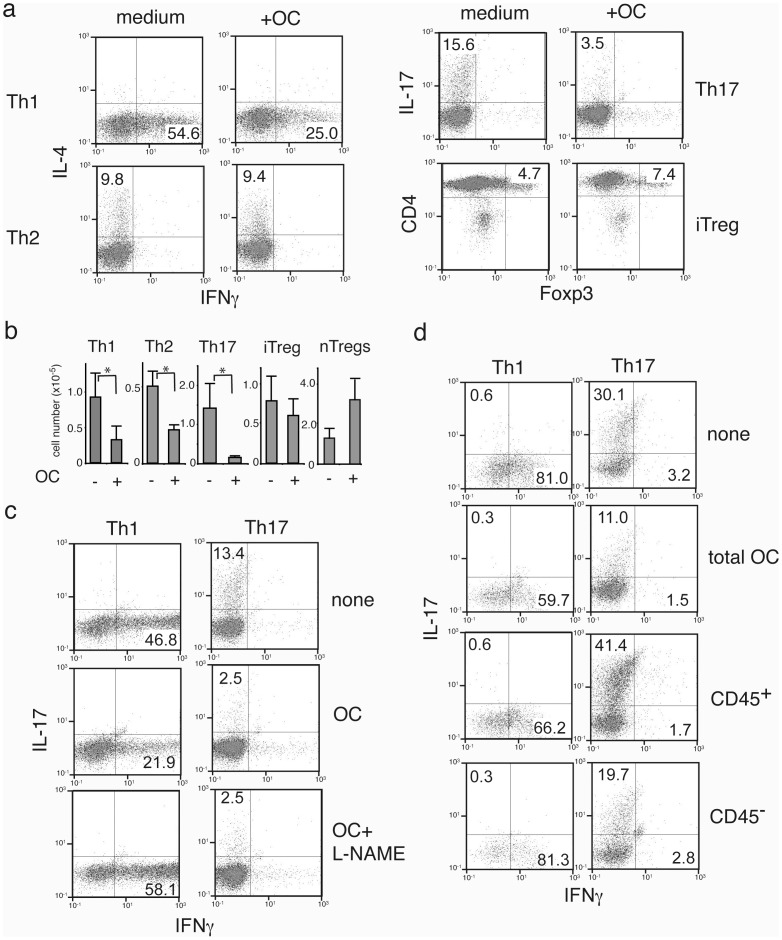
Suppression of effector but not regulatory T cells by omentum cells.(a) Immunosuppressive functions of omentum cells on effector T cells. Naïve CD4+ T cells were induced to differentiate into Th1, Th2, Th17, or iTregs. 5 days after induction, omentum cells were added to each group of cells. T cells were maintained further with the same culture medium for 2 days, harvested, and were stimulated with PMA and ionomycin for 4 hours to induce cytokine production. (b) Cells were cultured with (+) or without (−) omentum cells and treated as in (a). Cell numbers that are expressing IFNγ, IL-4, IL-17, or Foxp3 were determined after intracellular cytokine stain. For nTregs, CD4+CD25+ from spleen were expanded prior to co-culture for 2 weeks, then cultured with omentum cells for 2 days. (c) Effect of iNOS inhibitor on Th1 and Th17 inhibition by omentum cells. Differentiated Th1 or Th17 cells were cultured with omentum cells in the presence/absence of an iNOS inhibitor for 2 days as in (a). (d) Omentum cells were sorted into CD45− and CD45+ cells, then co-cultured with CD4+T cell differentiated into Th1 (upper panels) or Th17 (lower panels) cells for 5 days. After 2 days of co-culture, cells were harvested and cytokine profiles were determined as in (a).